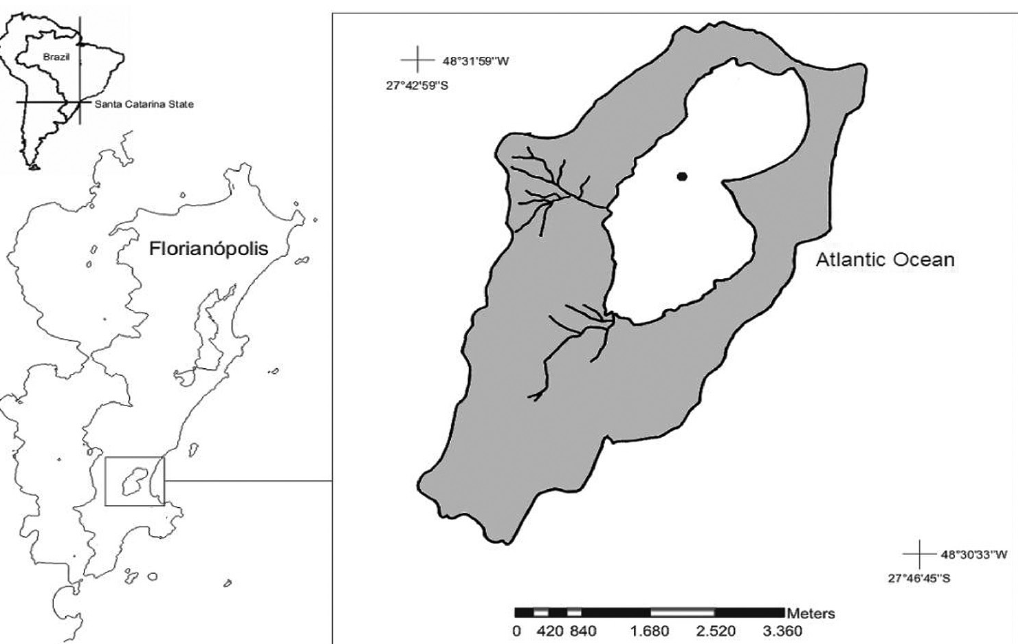
Figure 1. Map and location of the Peri Lake, Santa Catarina Island, Brazil, showing the sampled station. Adapted from Hennemann and Petrucio